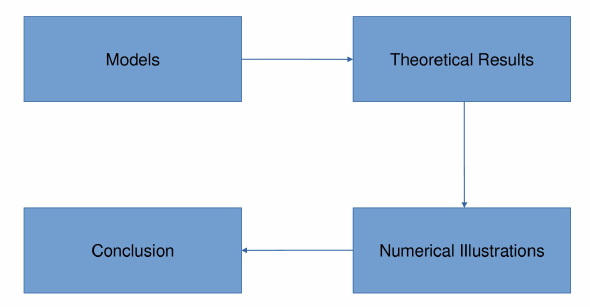
Figure 1. Outline of the work presented.